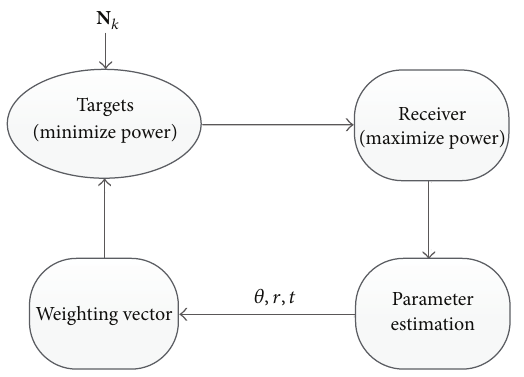
Figure 4: Block diagram of cognitive FDA feedback radar